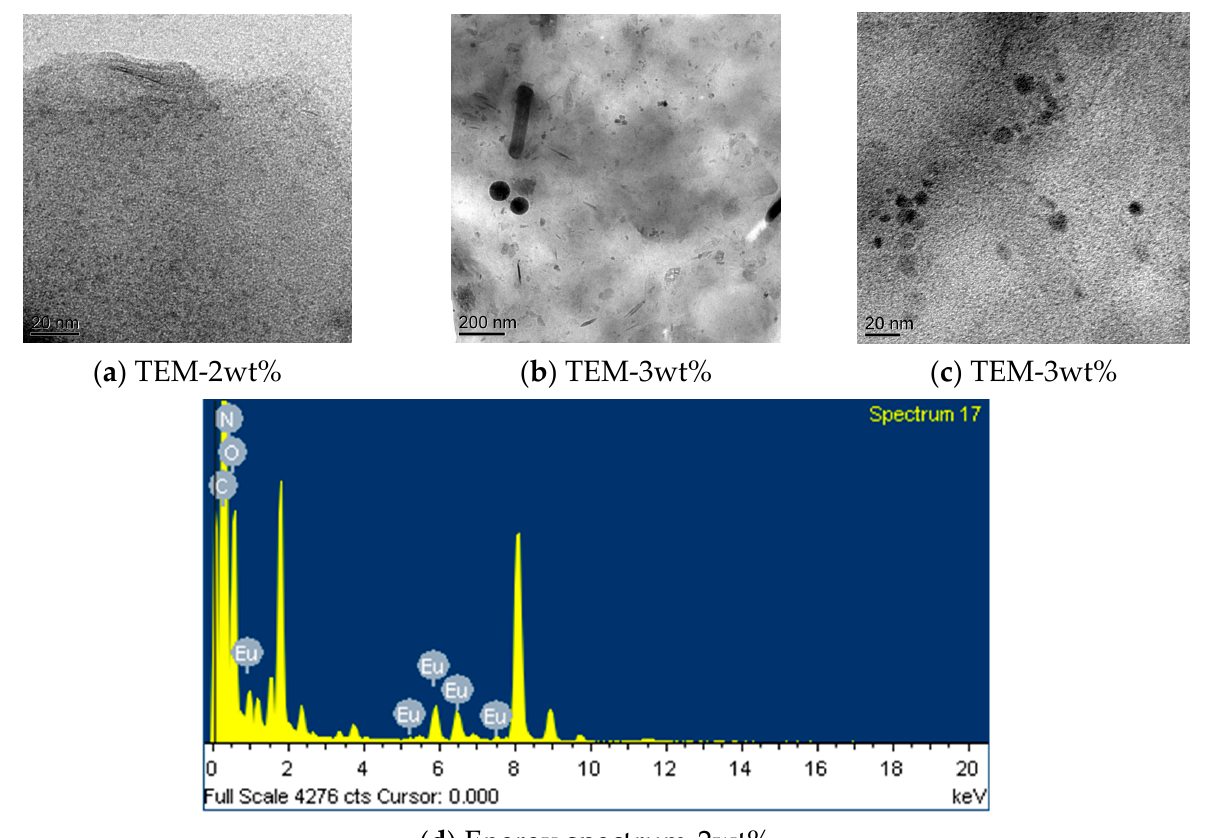
Figure 3. TEM images ( a – c ) and energy spectrum ( d ) of the polyurethane–europium materials containing 2 wt% and 3 wt% europium complex.